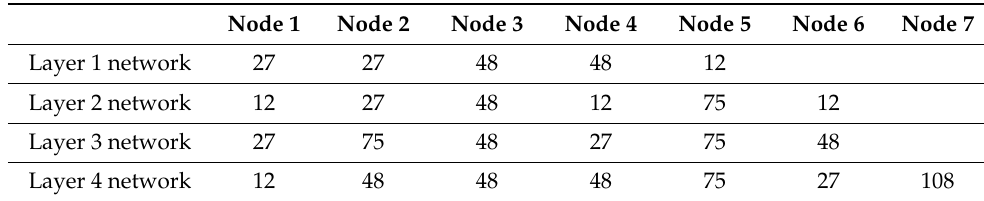
Table 4. Initial load of the node.